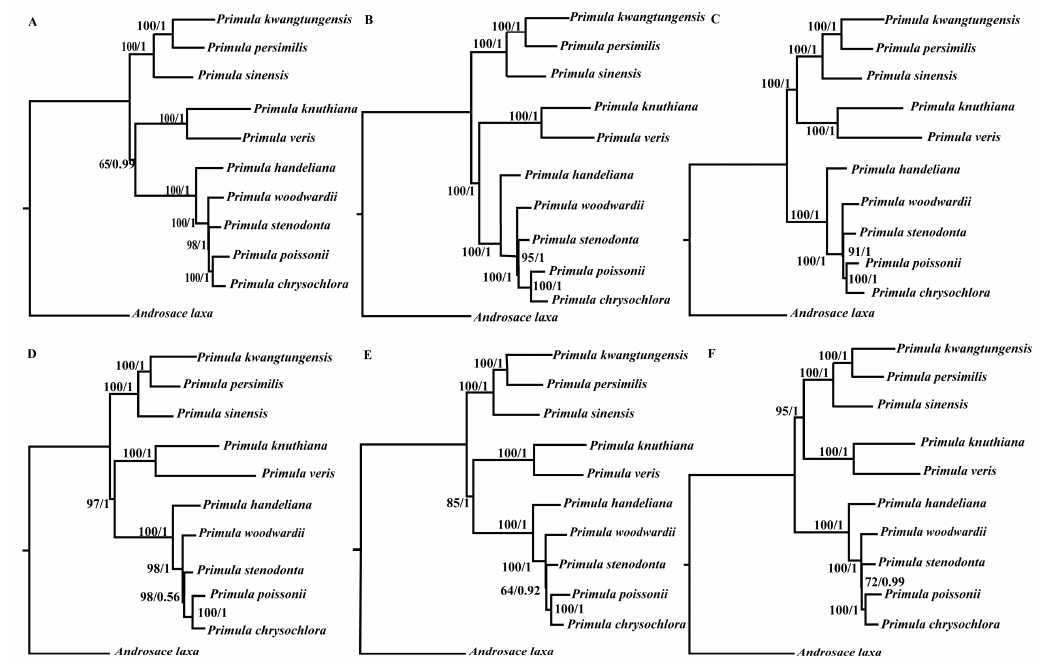
Figure 6. Phylogenetic relationships of the 10 Primula species and A. laxa inferred from ML and BI analyses. ( A ) Whole plastid genomes; ( B ) protein-coding regions; ( C ) introns and intergenic spacer regions; ( D ) IR regions; ( E ) SSC regions; and ( F ) LSC regions. The numbers near each node are bootstrap support values and posterior